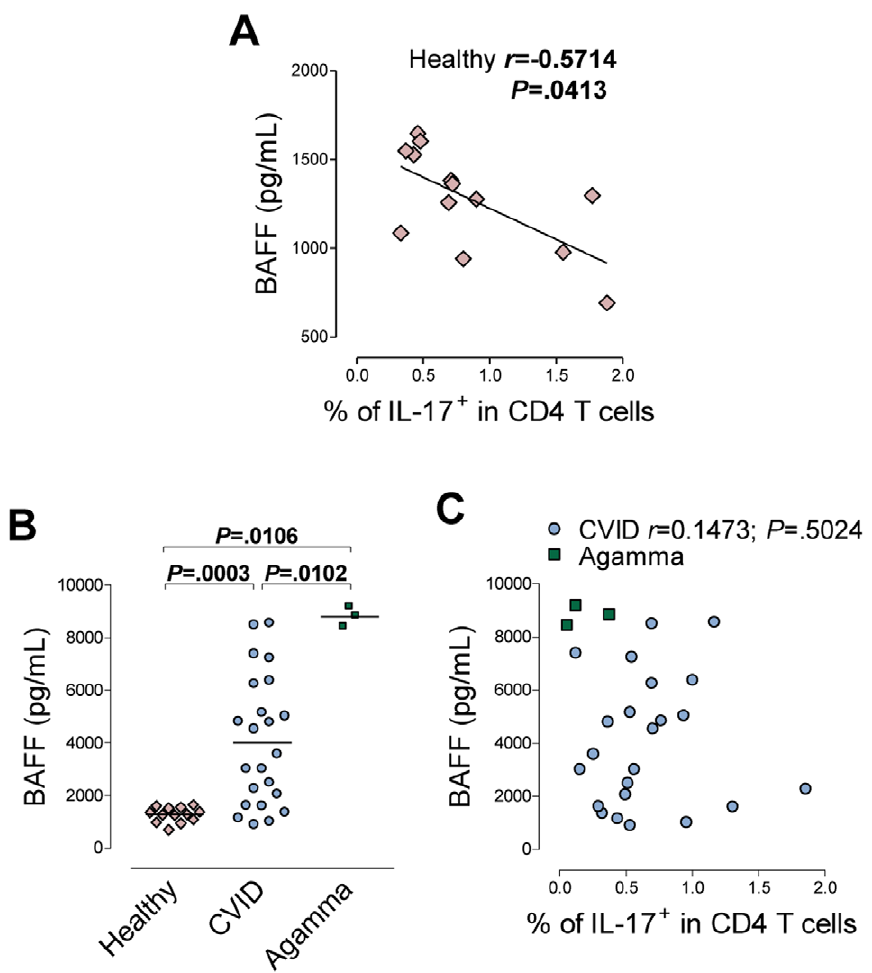
Figure 4. Negative correlation between the frequency of Th17 cells and serum BAFF levels in healthy subjects. (A) Correlation between the frequency of Th17 cells and serum levels of the cytokine BAFF, as determined by ELISA, in healthy individuals. (B) Analyses of the serum levels of BAFF in healthy individuals, CVID and Congenital Agammaglobulinemia patients. Each symbol represents one individual. Data were compared using Mann-Whitney test, and P values are shown. (C) The same correlation described in (A) for CVID patients and Congenital Agammaglobulinemia patients. Each symbol represents one individual. Correlation significance was determined using Spearman coefficient test, and r and P values are shown.